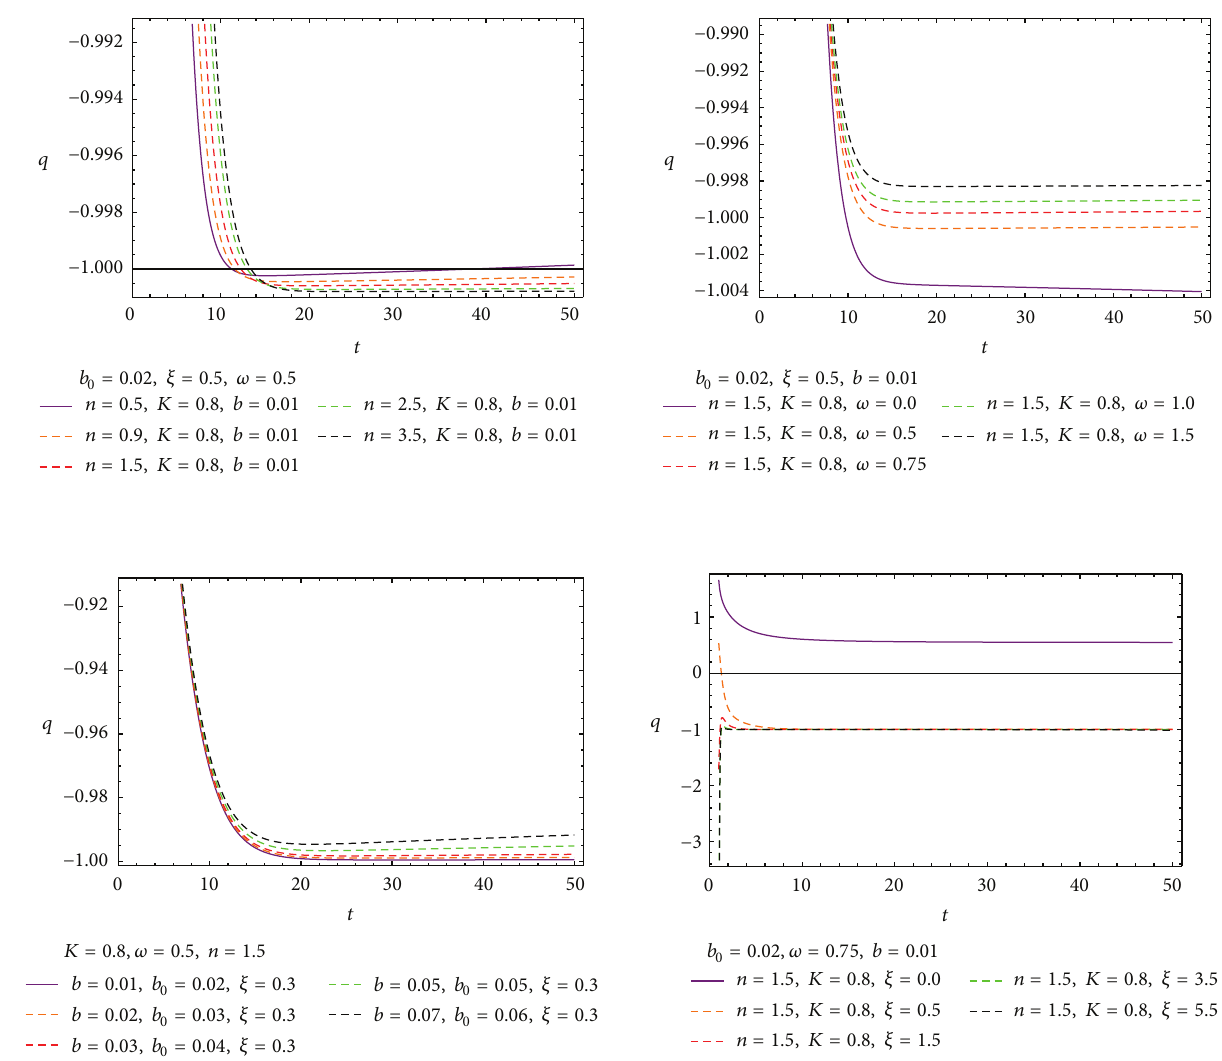
Figure 6: Behavior of deceleration parameter 𝑞 against 𝑡 for interacting barotropic fluid and viscous polytropic gas.